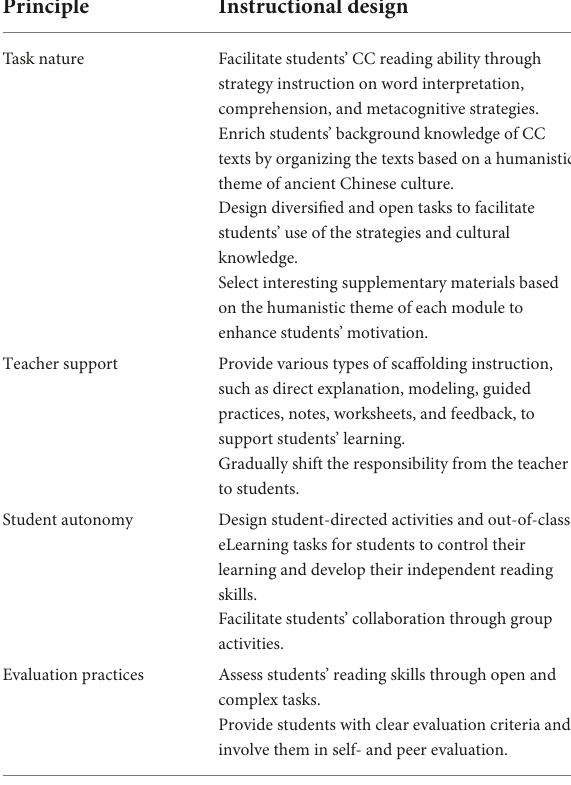
TABLE 1 Brief description of the intervention design.